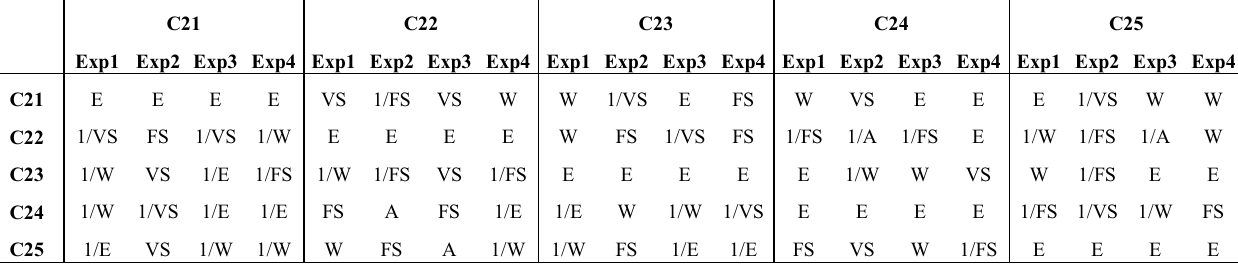
Table 10: Expert Evaluations of sub-criteria (C21-C25) with respect to Firm Related Factors